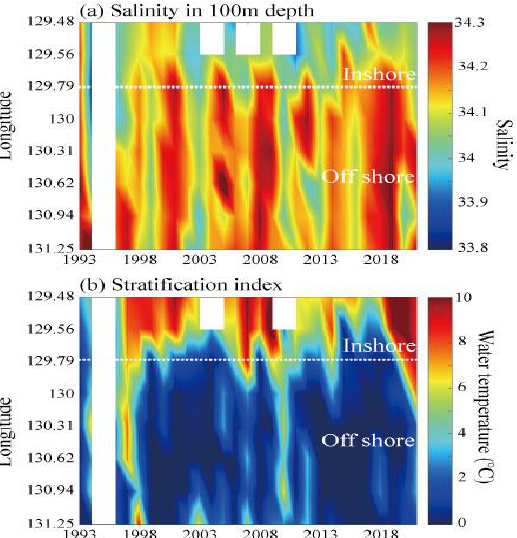
Figure 7. Long-term changes in ( a ) salinity at 100 m depth and ( b ) stratification index.